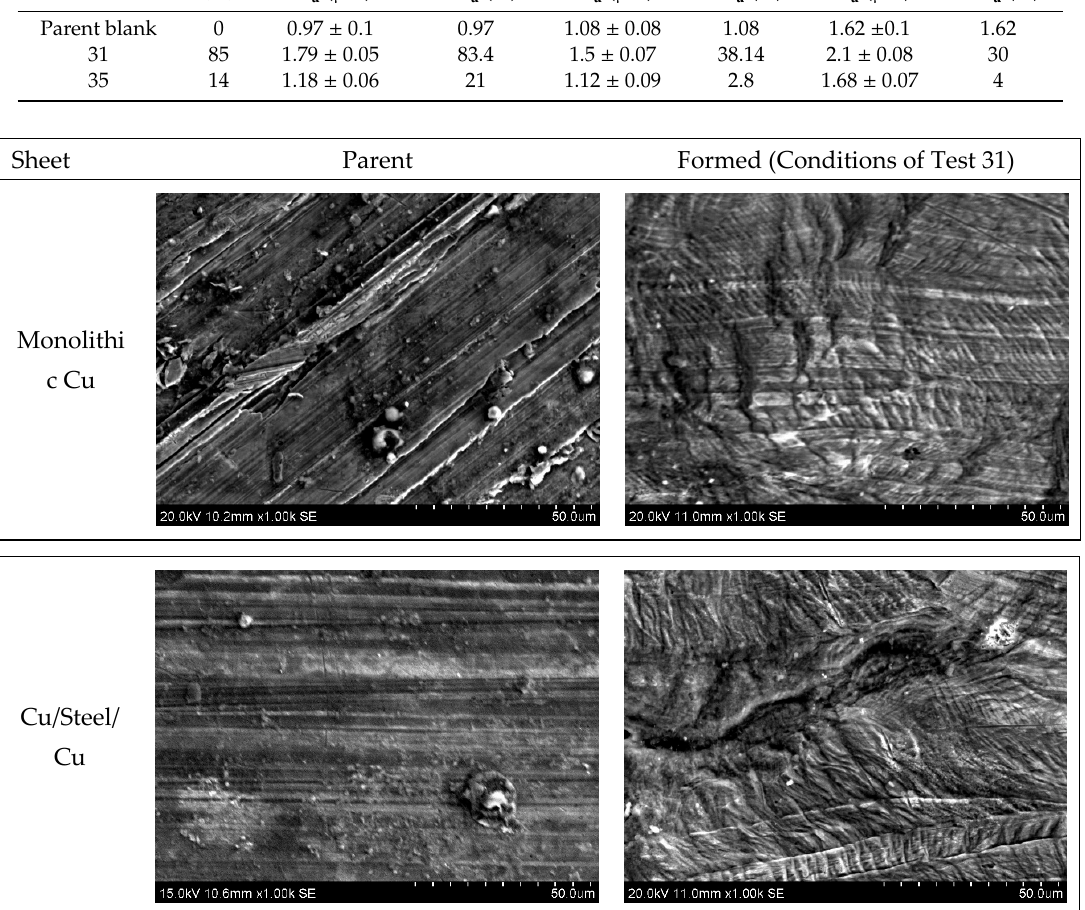
Table 4. Comparison of free-surface roughness in the layered and monolithic sheets.